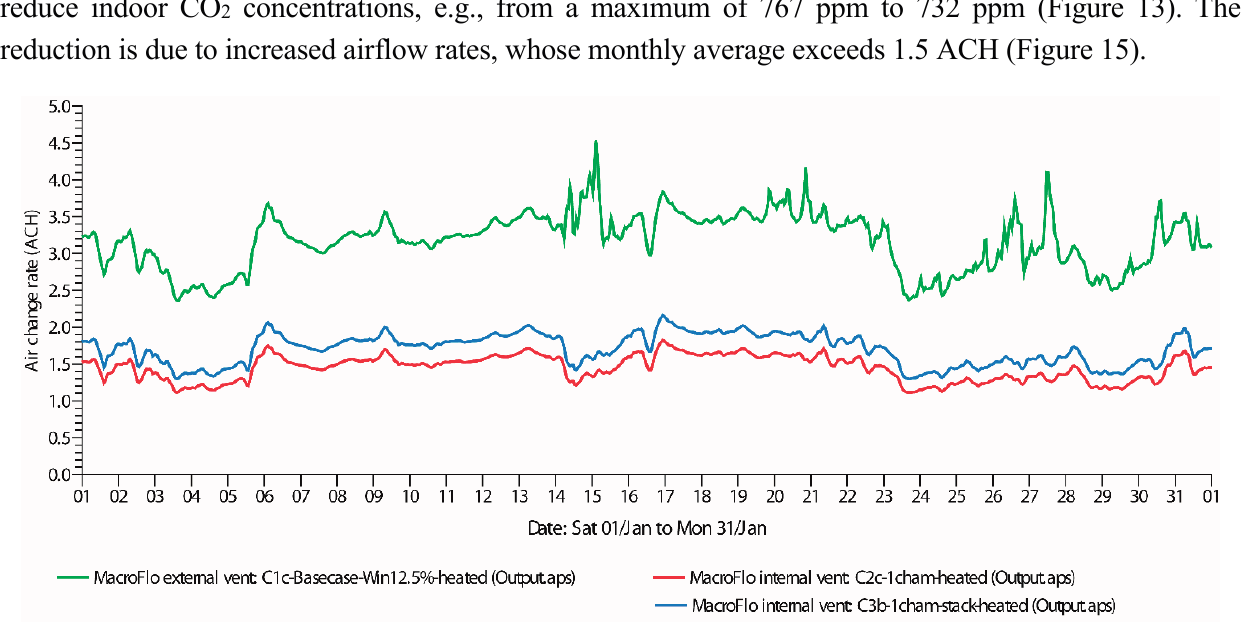
Figure 4. Predicted ventilation rates for heated base case (Case 1c) and heated NVHR Cases 2c and